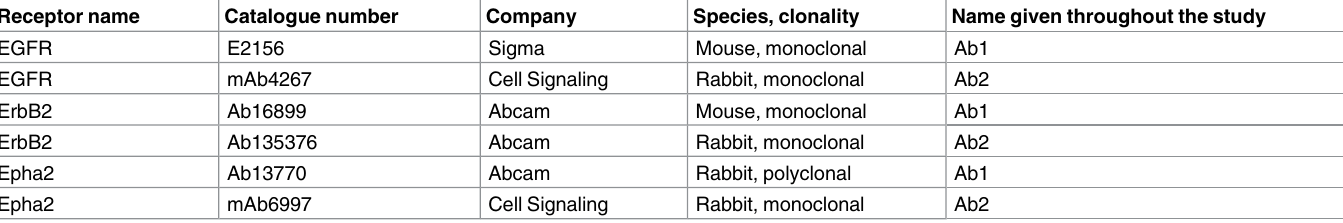
Table 1. List of antibodies